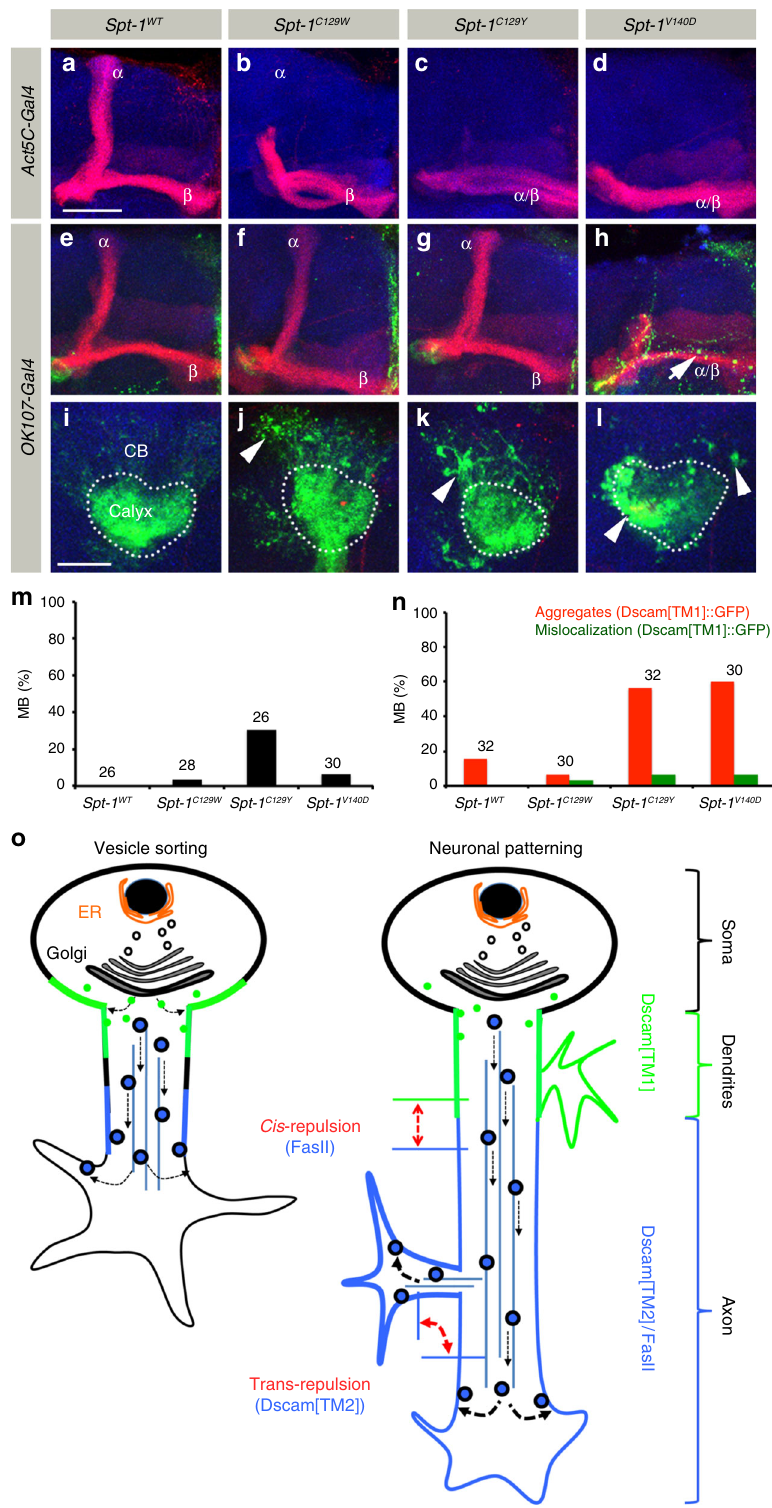
not detect a direct correlation between the affected ceramide species and the axonal phenotype, suggesting that the overall reduction in the levels of ceramides results in disruption of axon-dendritic protein sorting. On the other hand, we did not fi nd any reduction in the total levels of membrane phospholipid PC and another sphingolipid Ceramide-phosphoethanolamine (Cer-PE), a downstream product of ceramide. This suggests